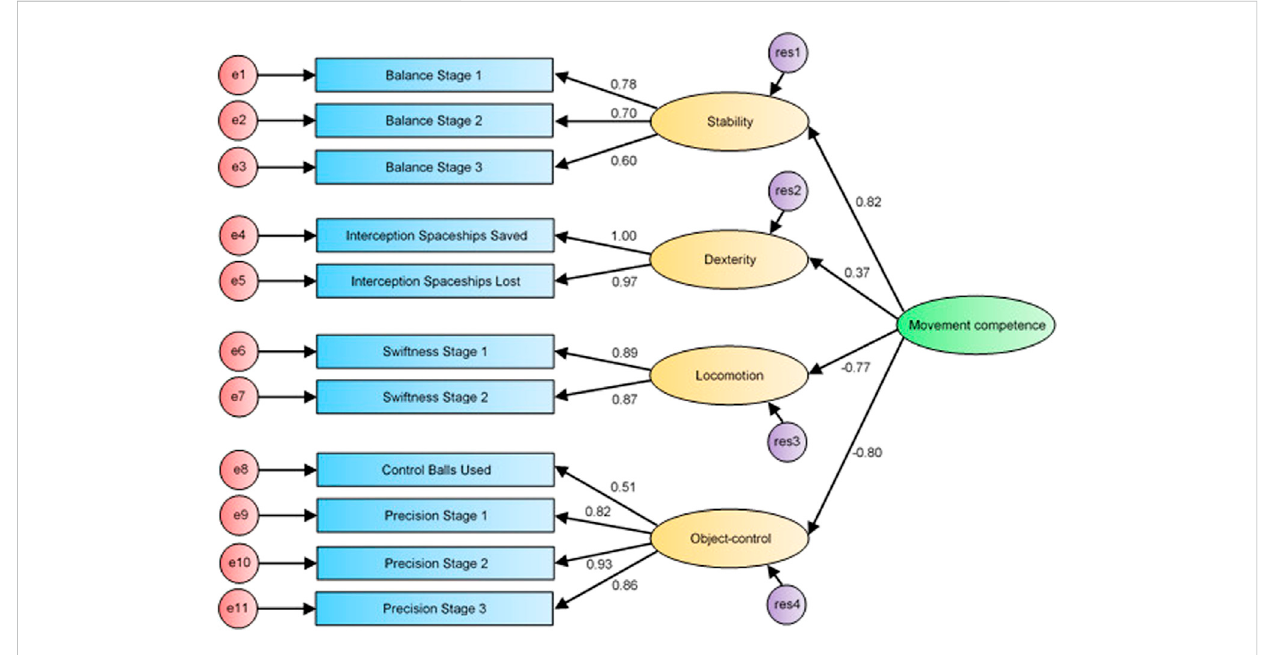
FIGURE 3 Second order CFA model for movement competence.